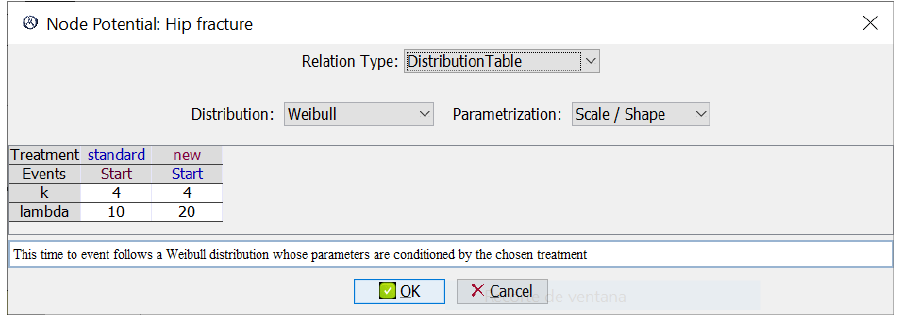
Figure 2. Potential for the event ‘Hip fracture’. It has one time-to-event Weibull distribution for each treatment. The scale parameter, λ , is higher for the new treatment because it tends to delay the occurrence of